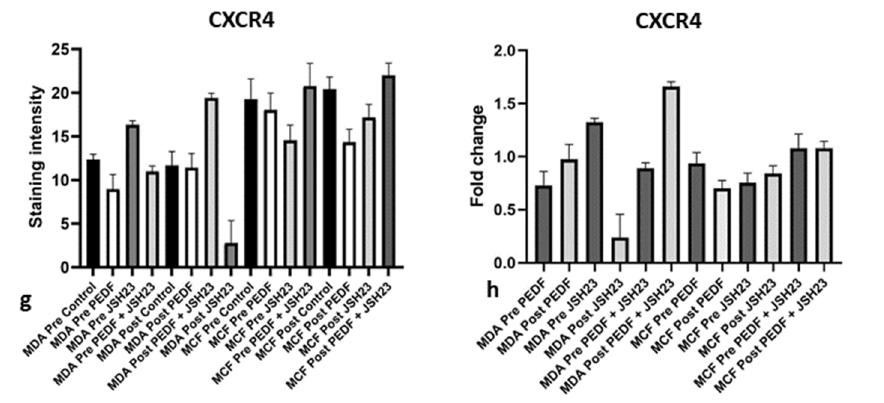
Figure 3. Biomarker expression following PEDF and JSH-23 treatment in MCF-7 and MDA-MB-231 cells in pre- and post-menopausal conditions. Biomarker expression via immunocytochemistry staining (blue) in cells following incubation in pre- (E1: 258 pM; E1S: 4130 pM; E2: 271 pM) or post-menopausal (E1: 72 pM; E1S: 541 pM; E2: 14.6 pM) levels of oestrogens and treatment with PEDF (100 nM), JSH-23 (20 µM), PEDF (100 nM) + JSH-23 (20 µM), or control for 24-h. Phosphorylated (p-)NF κ B-p65 expression under pre-menopausal conditions in MCF-7 treated with control ( A ), PEDF ( B ), JSH-23 ( C ), or PEDF + JSH-23 ( D ) and in MDA-MB-231 treated with control ( I ), PEDF ( J ), JSH-23 ( K ), or PEDF + JSH-23 ( L ), and under post-menopausal conditions in MCF-7 treated with control ( E ), PEDF ( F ), JSH-23 ( G ), or PEDF + JSH-23 ( H ) and in MDA-MB-231 treated with control ( M ), PEDF ( N ), JSH-23 ( O ), or PEDF + JSH-23 ( P ). TNF- α expression under pre-menopausal conditions in MCF-7 treated with control ( Q ), PEDF ( R ), JSH-23 ( S ), or PEDF + JSH-23 ( T ) and in MDA-MB-231 treated with control ( Y ), PEDF ( Z ), JSH-23 ( AA ), or PEDF + JSH-23 ( AB ), or under post-menopausal conditions in MCF-7 treated with control ( U ), PEDF ( V ), JSH-23 ( W ), or PEDF + JSH-23 ( X ) and in MDA-MB-231 treated with control ( AC ), PEDF ( AD ), JSH-23 ( AE ), or PEDF + JSH-23 ( AF ). CXCR4 expression under pre-menopausal conditions in MCF-7 treated with control ( AG ), PEDF ( AH ), JSH-23 ( AI ), or PEDF + JSH-23 ( AJ ) and in MDA-MB-231 treated with control ( AO ), PEDF ( AP ), JSH-23 ( AQ ), or PEDF + JSH-23 ( AR ) or under post-menopausal conditions in MCF- treated with control ( AK ), PEDF ( AL ), JSH-23 ( AM ), or PEDF + JSH-23 ( AN ) and in MDA-MB-231 treated with control ( AS ), PEDF ( AT ), JSH-23 ( AU ), or PEDF + JSH-23 ( AV ). uPAR expression under pre-menopausal conditions in MCF-7 treated with control ( AW ), PEDF ( AX ), JSH-23 ( AY ), or PEDF + JSH-23 ( AZ ) and in MDA-MB-231 treated with control ( BE ), PEDF ( BF ), JSH-23 ( BG ), or PEDF + JSH-23 ( BH ) or under post-menopausal conditions in MCF-7 treated with control ( BA ), PEDF ( BB ), JSH-23 ( BC ), or PEDF + JSH-23 ( BD ) and in MDA-MB-231 treated with control ( BI ), PEDF ( BJ ), JSH-23 ( BK ), or PEDF + JSH-23 ( BL ). Biomarker staining intensity in cells treated with control, PEDF, JSH-23, or PEDF + JSH-23 for p-NF κ B-p65 ( a ) TNF- α ( c ), uPAR ( e ), and CXCR4 ( g ). Biomarker fold change in PEDF-treated cells versus control in pre- or post-menopausal conditions for p-NF κ B-p65 ( b ), TNF- α ( d ), uPAR ( f ), and CXCR4 ( h ). Scale bar 50 µM .